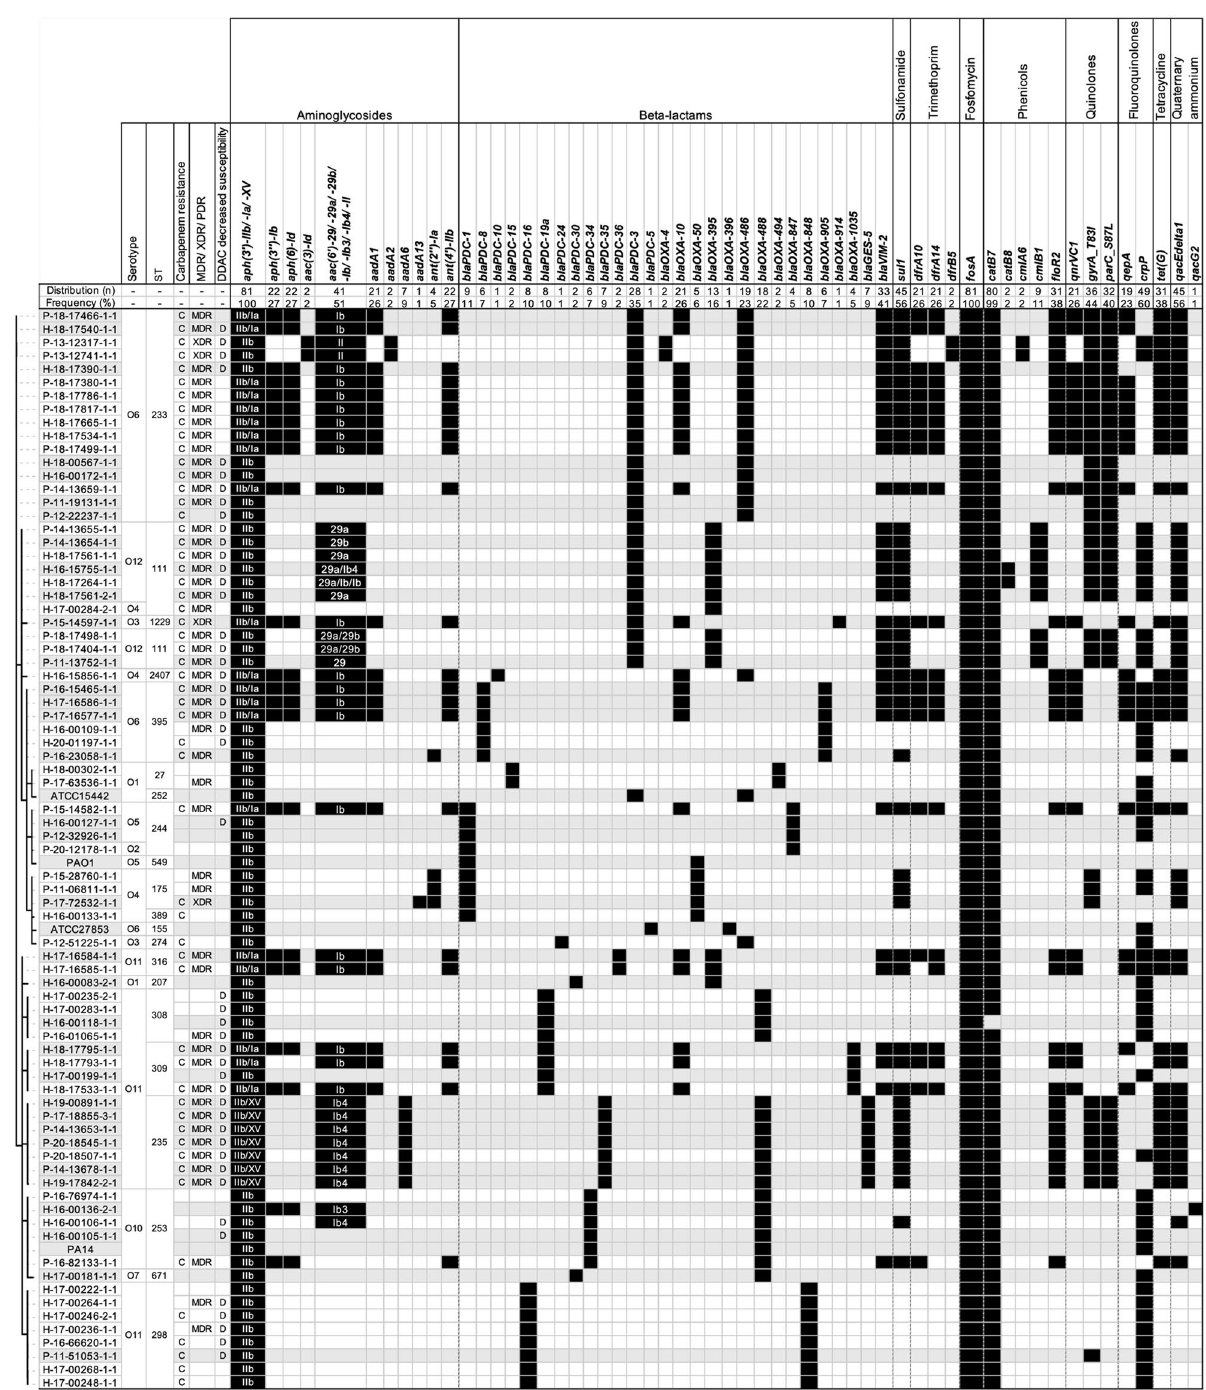
Figure 5. Antimicrobial resistance-associated genes of 77 strains from panel for genomic characterization compared with reference strains (PAO1, PA14, ATCC15442 and ATCC27853). Strains were organized according to the cgMLST minimum distance tree. The serotype (O), the sequence type (ST), the presence of a carbapenem resistance (imipenem and/or meropenem) phenotype, whether the strain was MDR, XDR, or PDR, and the presence of a decreased susceptibility to DDAC phenotype (D) are mentioned. The sub-variants of the aph(3 ′ ) gene were grouped as well as the sub-variants of aac(6 ′ ) , in case of co-occurrence of these sub-variants they were indicated and separated by a slash. C, Strains with carbapenems resistance; H, Strains isolated from the hospital environment; P, Strains isolated from patients; MDR, Multidrug-resistant; XDR, Extensively drug-resistant; PDR: